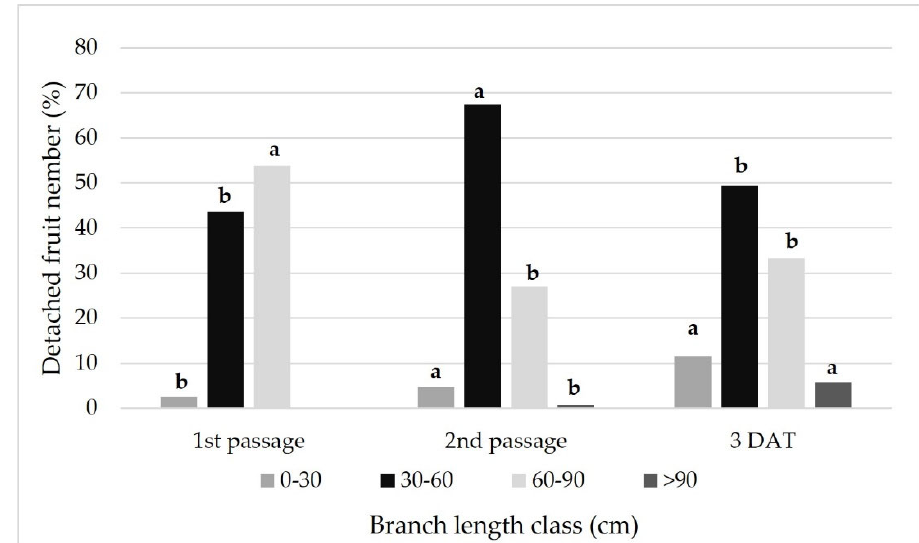
Figure 5. Percentage of detached fruits during the first and second passage and 3 days after mechanical thinning, based on length of branches. Means followed by the same letter do not differ significantly at p ≤ 0.05 according to Duncan’s test. Statistical comparisons were carried out within each branch length class.